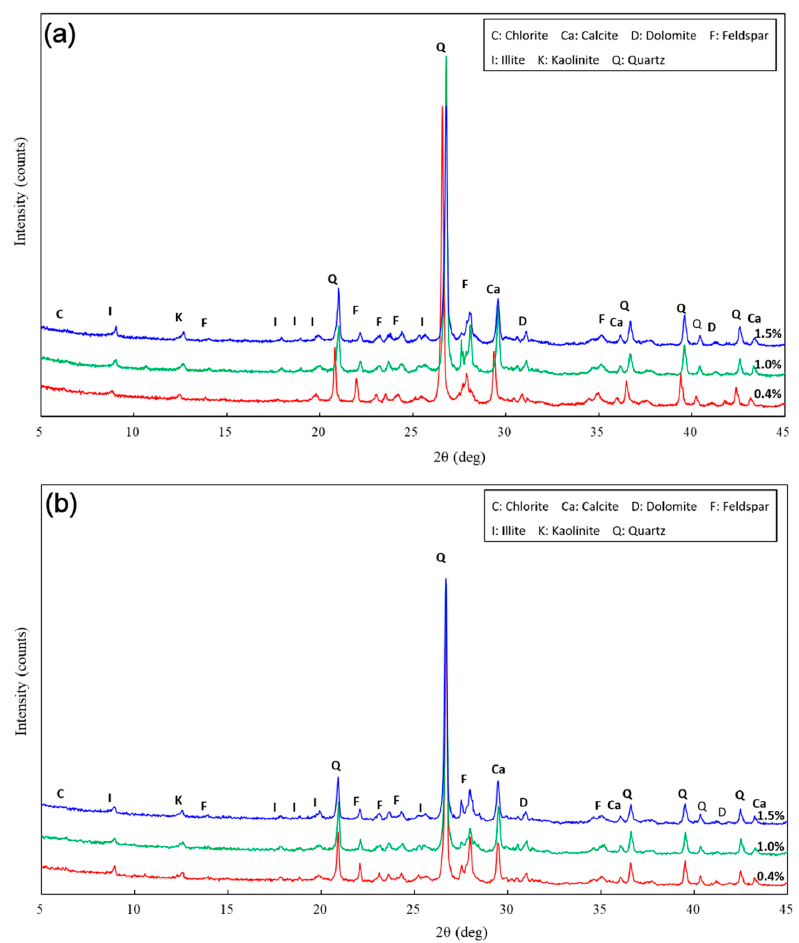
Figure 12. Mineralogical composition of the treated loess with specified nano-SiO 2 contents after curing for 28 and 60 days.